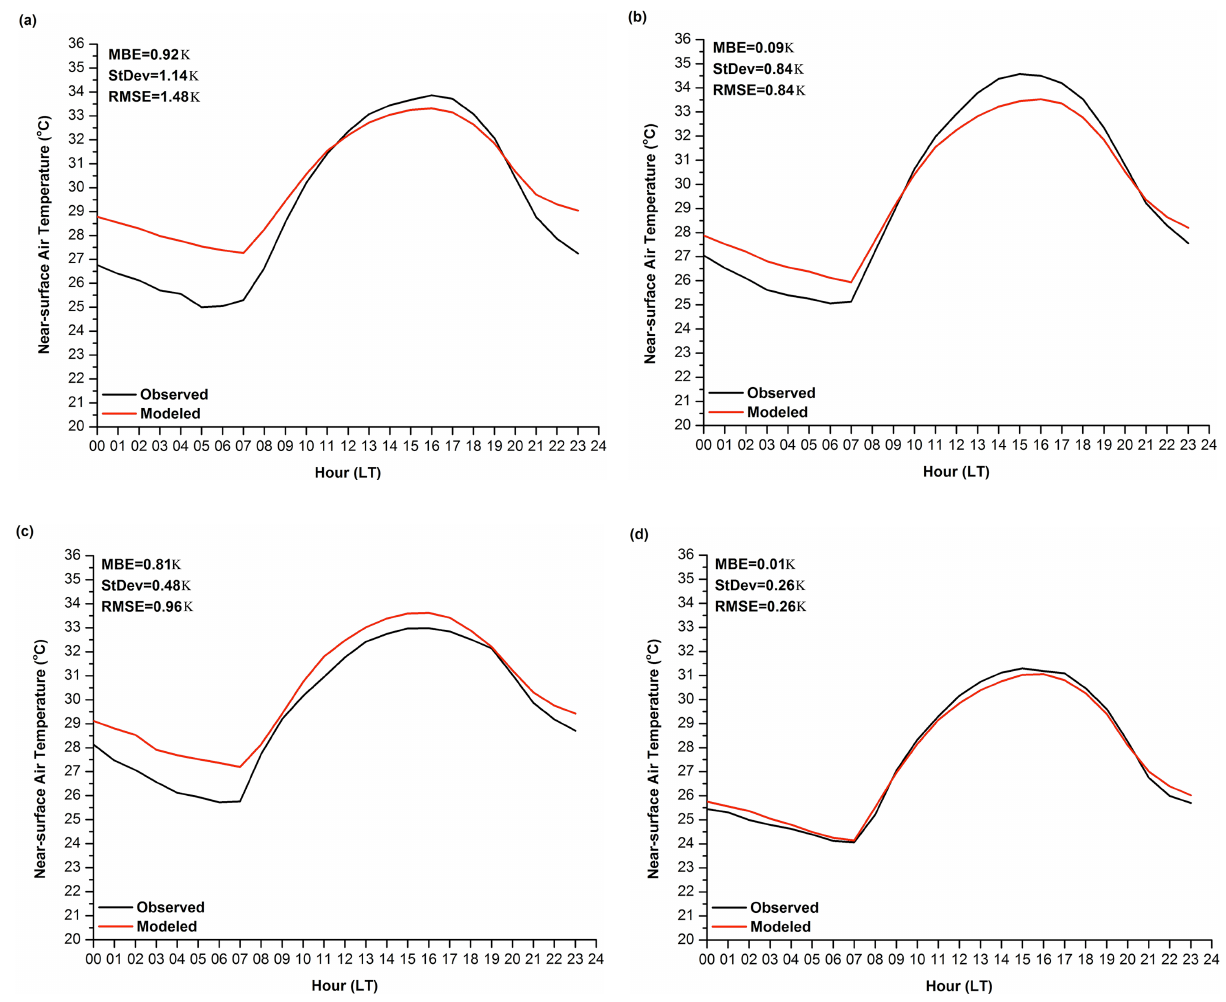
Fig. 7. Diurnal course of the near-surface air temperature averaged from 00:00UTC 13 July to 23:00UTC 27 August 2010 for (a) DUF, (b) IOC, (c) URB, and (d) RUR sites. Statistical parameters are presented within the plots (MBE, RMSE, StDev: Standard